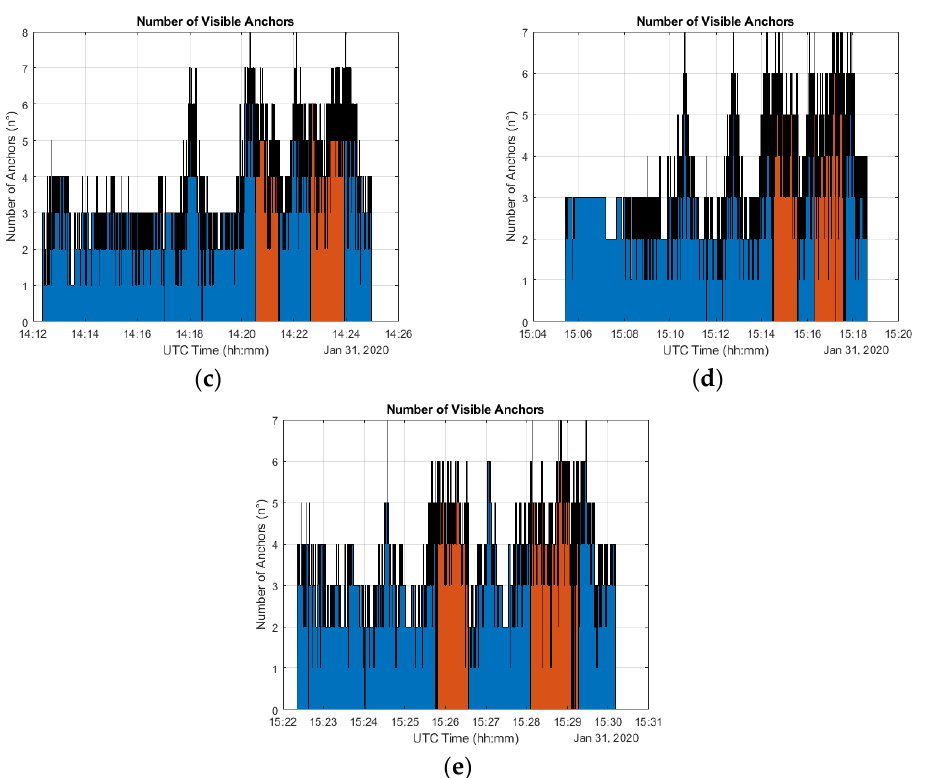
Figure 5. Number of measured ranges by the moving tag during the acquisition time for five different tests ( a – e ). Ranges are both in LOS and NLOS conditions.